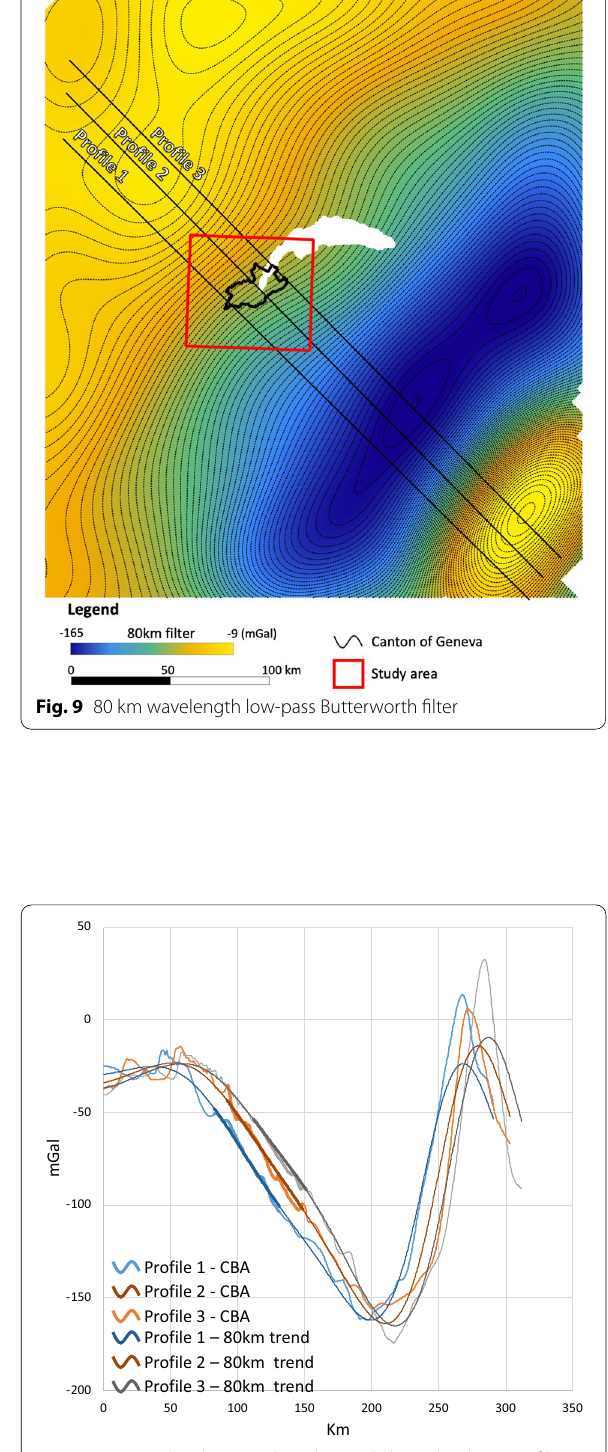
Fig. 10 CBA and 80 km wavelength signal along the three profiles through the study area. Thicker lines highlight the signal over